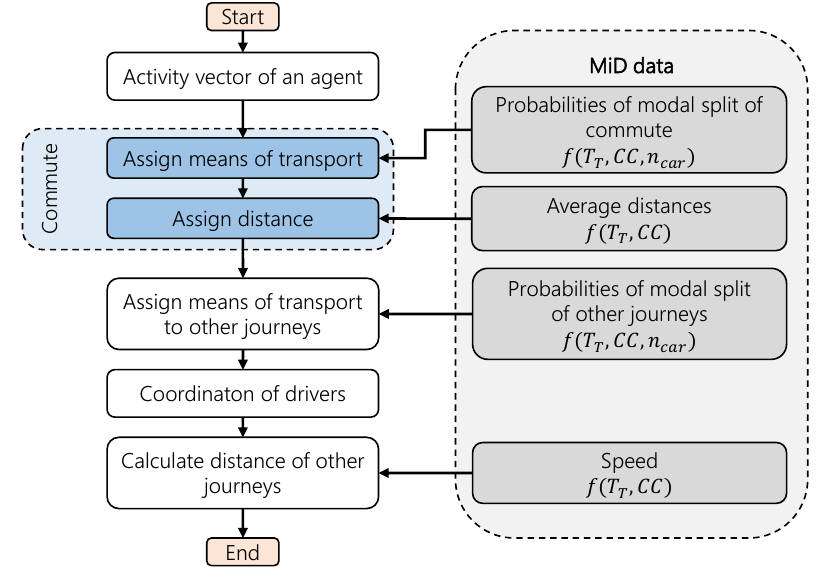
Figure 4. Flow chart of the moblity